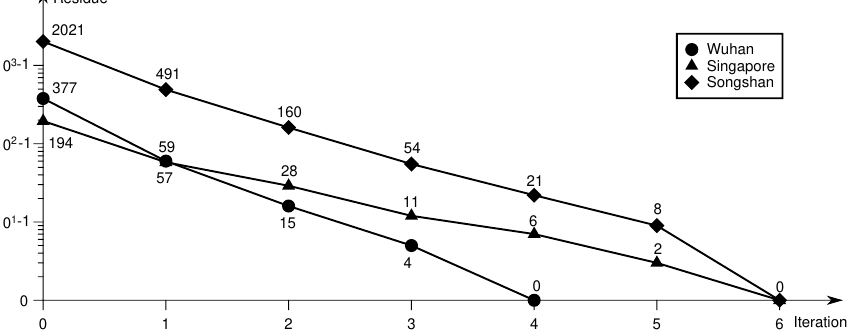
Figure 11. Numbers of unbalanced residues in the coupling iterations in the experimental data. After aligning the regions for the global frame, Poisson solving with the Dirichlet boundary condition provided the initial unwrapped phase, considering the discontinuities defined in Equation (14). The initial solutions were obtained from four times of PCR itera- tive solving with wrapped phase differences along the horizontal and vertical